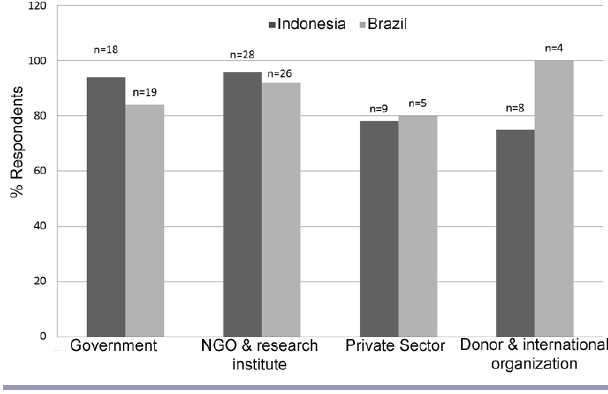
Fig. 2 . Percentage of respondents in the social organization survey in Brazil and Indonesia that agreed with the statement “REDD should mainly reward local people for emission reduction activities.” Note: For the composition of the four categories, see Fig. 1.